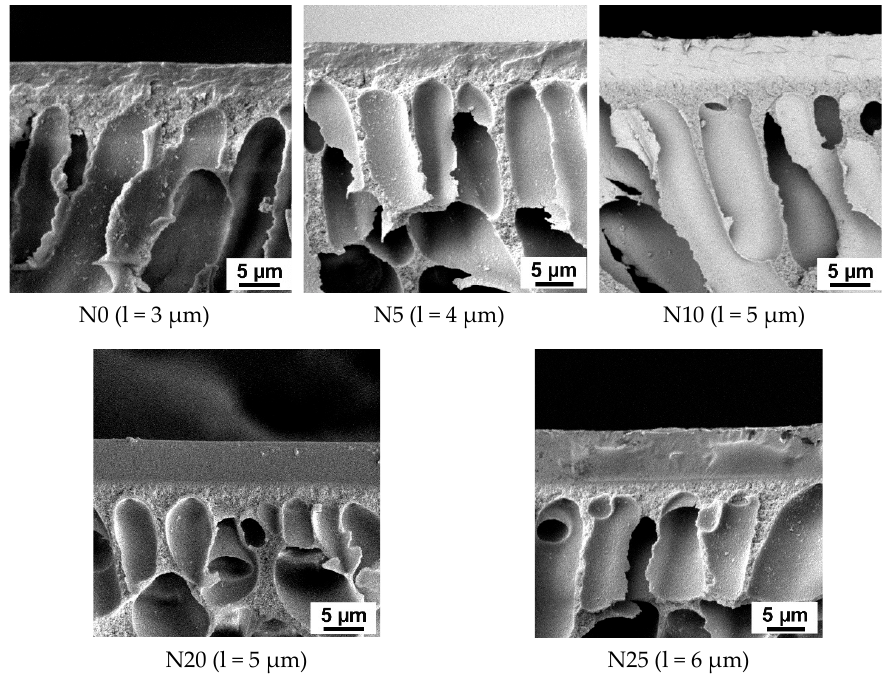
Figure 1. SEM microphotographs of TFC membrane cross-sections with different content of Al 2 O 3 ·SiO 2 nanoparticles.